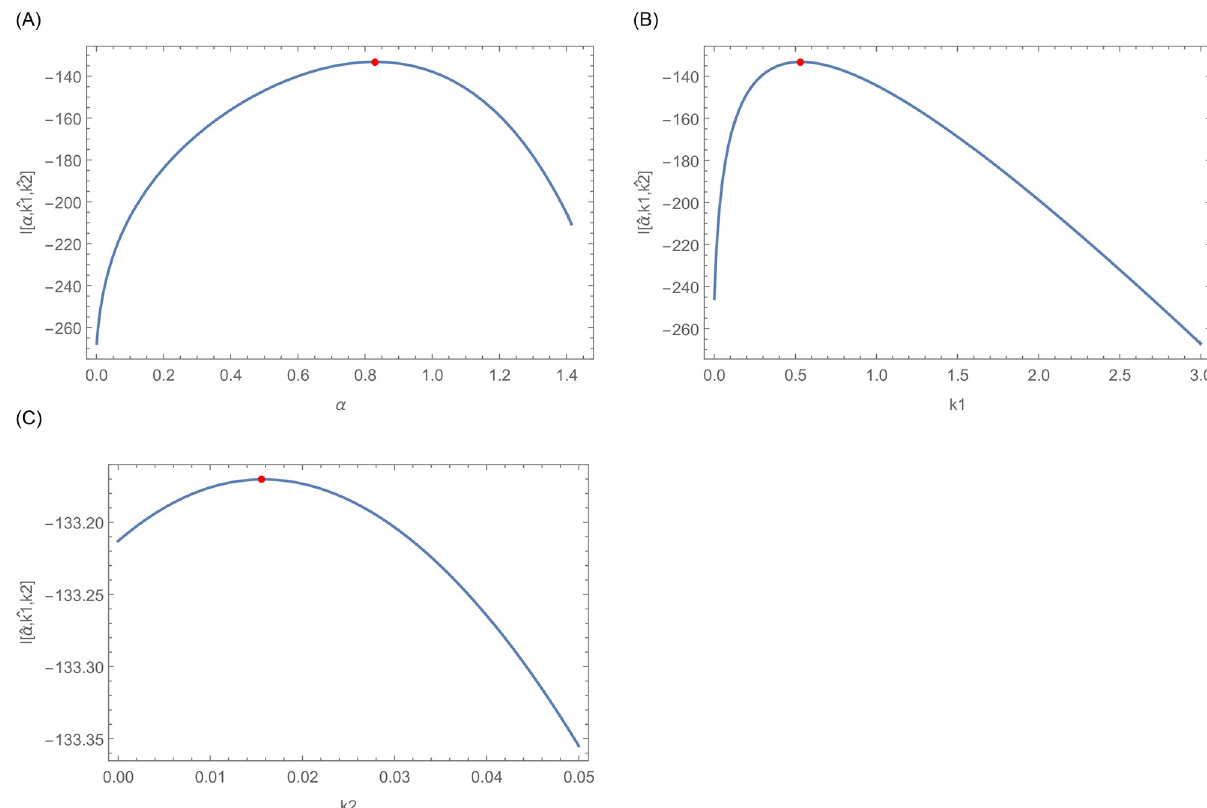
Fig 16. This figure indicates that the log likelihood roots are global maximum.